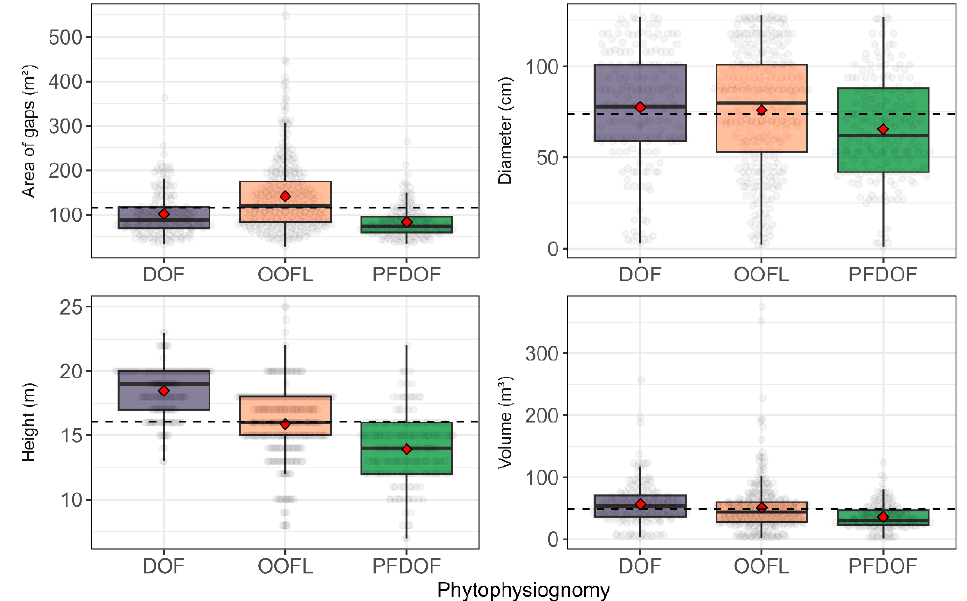
Figure 2. Box plot for the area of gaps (dependent variable) and the dendrometric variables measured in the felled trees, arranged by phytophysiognomy. Vertical bars (black color): Q1 − 1.5 × IQR (1st quartile minus 1.5 times the interquartile range) and Q3 + 1.5 × IQR (3rd quartile plus 1.5 times the interquartile range); red points: arithmetic mean of the variables of each phytophysiognomies; horizontal dashed lines (black color) in each sub- \ figure: arithmetic mean of the variable in the sample. PFDOF: periodically flooded dense ombrophilous forest; DOF: dense ombrophilous forest; OOFL: open ombrophilous forest with lianas.